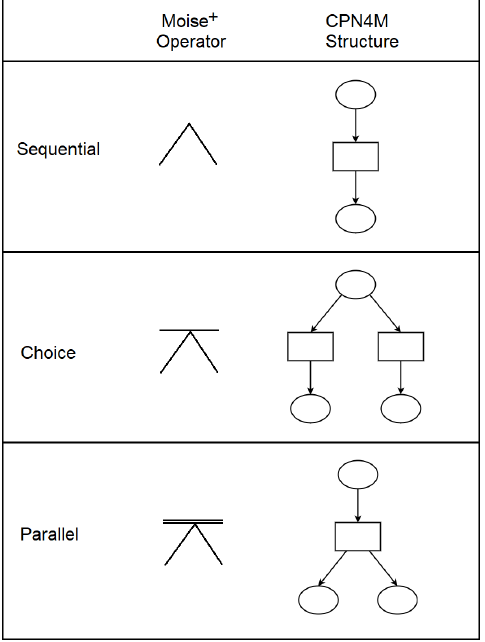
Figure 6. A mapping between FS operators and CPN4M